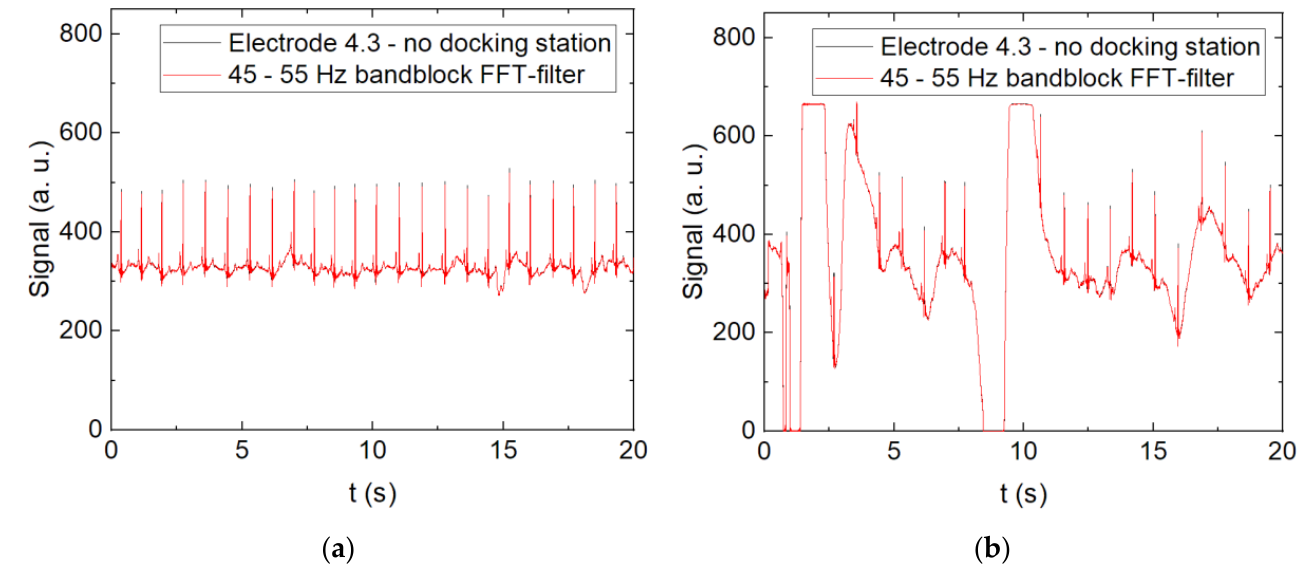
Figure 5. ECG measurement with textile electrode 4.3: ( a ) sitting without movement; ( b ) slightly